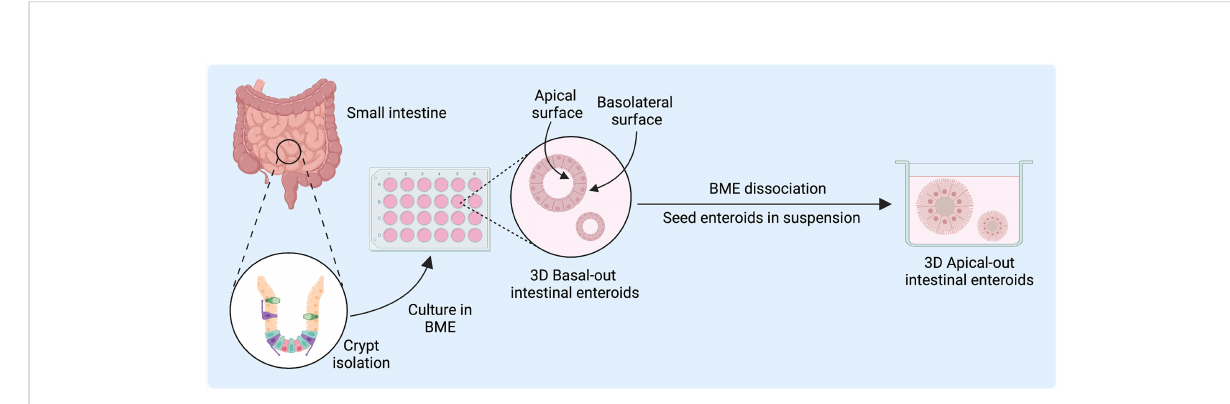
FIGURE 1 Human intestinal enteroid (HIE) derivation and culture for host-pathogen and disease modeling. HIEs are derived from the intestinal crypts and directly embedded into basement membrane-like matrix (BME) to generate epithelial enteroid cultures with differentiated cell types to model host-virus interactions. Figure created with